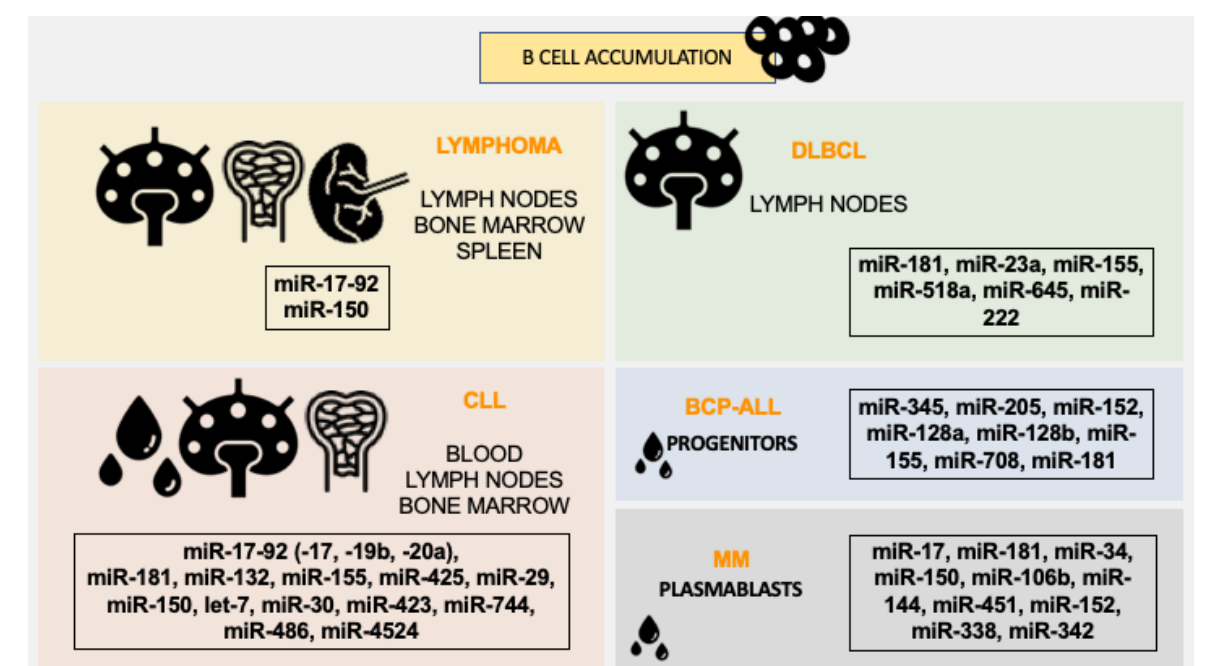
Figure 3. OncomiRs related to B-cell accumulation and proliferation in hematological B malignancies: Lymphoma, DLBCL, CLL, BCP-ALL and MM. Lymphoma disease is characterized by the accumulation of cells in lymph nodes, bone marrow and spleen. MicroRNAs miR-17-92 and miR-150 are known to regulate cell numbers in these organs. DLBCL (Diffuse large B-cell lymphoma) present B-cell number increased in lymph nodes, and microRNAs miR-181, miR-23a, miR-155, miR-518a, miR-645 and miR-222 can interfere in this accumulation. CLL (Chronic Lymphocytic Leukemia) has a higher number of B-cells in blood, lymph nodes and bone marrow, where miR-17-92 (-17, -19b, -20a), miR-181, miR-132, miR-155, miR-425, miR-29, miR-150, let-7, miR-30, miR-423, miR-744, miR-486 and miR-4524 showed a role in control cell accumulation and proliferation in these tissues. BCP-ALL (B-Cell Precursor Acute Lymphoblastic Leukemia) is the accumulation of B-cell progenitors in blood and microRNAs miR-345, miR-205, miR-152, miR-128a, miR-128b, miR-155, miR-708 and miR-181 are characterized as biomarkers of B-cell number control. Lastly, MM (Multiple myeloma) where plasma blasts accumulate in the blood, has microRNAs miR-17, miR-181, miR-34, miR-150, miR-106b, miR-144, miR-451, miR-152, miR-338, miR-342 as regulators of proliferation and accumu-